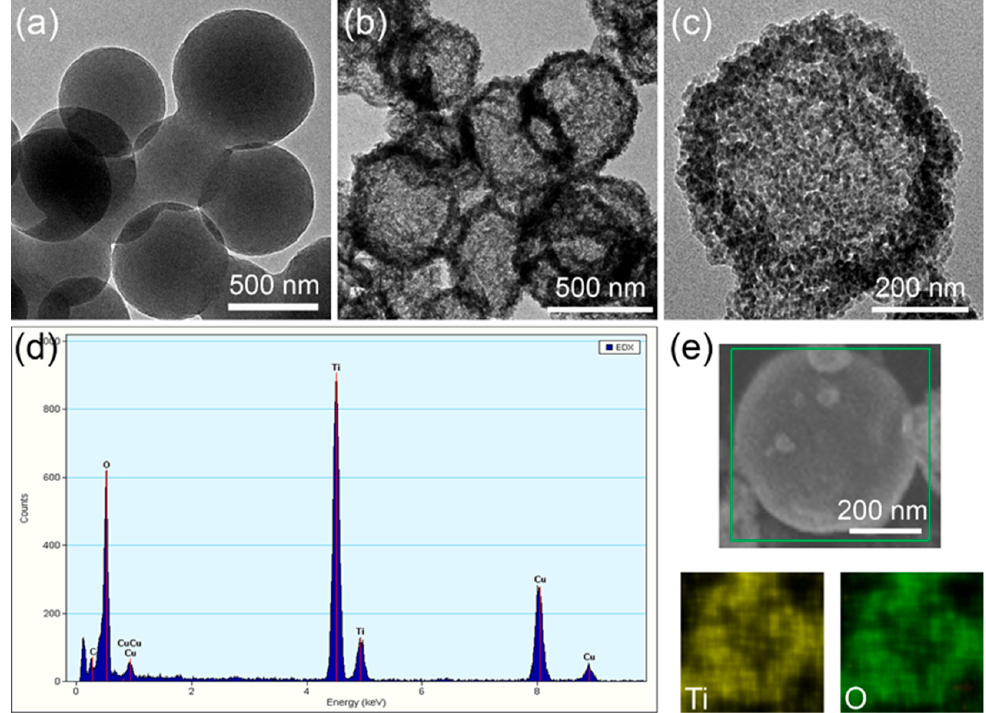
Figure 2. ( a ) TEM image of CS template; ( b ) TEM image of TiO 2 HMS in low magnification; ( c ) magnified TEM image of TiO 2 HMS; ( d ) EDS of TiO 2 HMS; ( e ) SEM elemental mapping scan results of a single TiO 2 HMS.